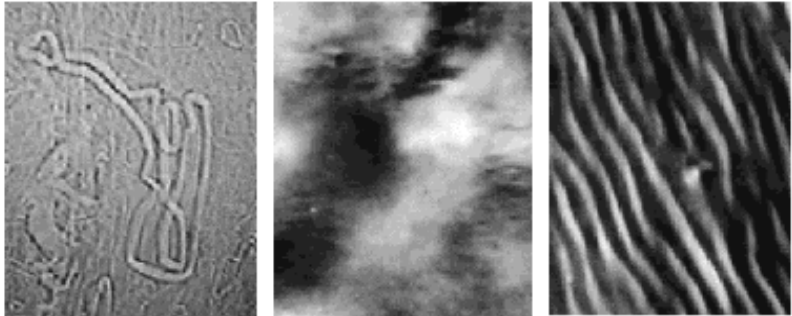
Figure 6. Optical anisotropic textures observed by polarising microscopy, at 20 °C, in water-sodium deoxycholate ( NaDC ) mixtures. From the left, fibres (26.6 wt %), random and ordered anisotropic domains (47.1 wt %), at equilibrium, or by shearing the sample between glass slides. The last image suggests rod-like, or fibre-like, arrangement. Magnification is 200